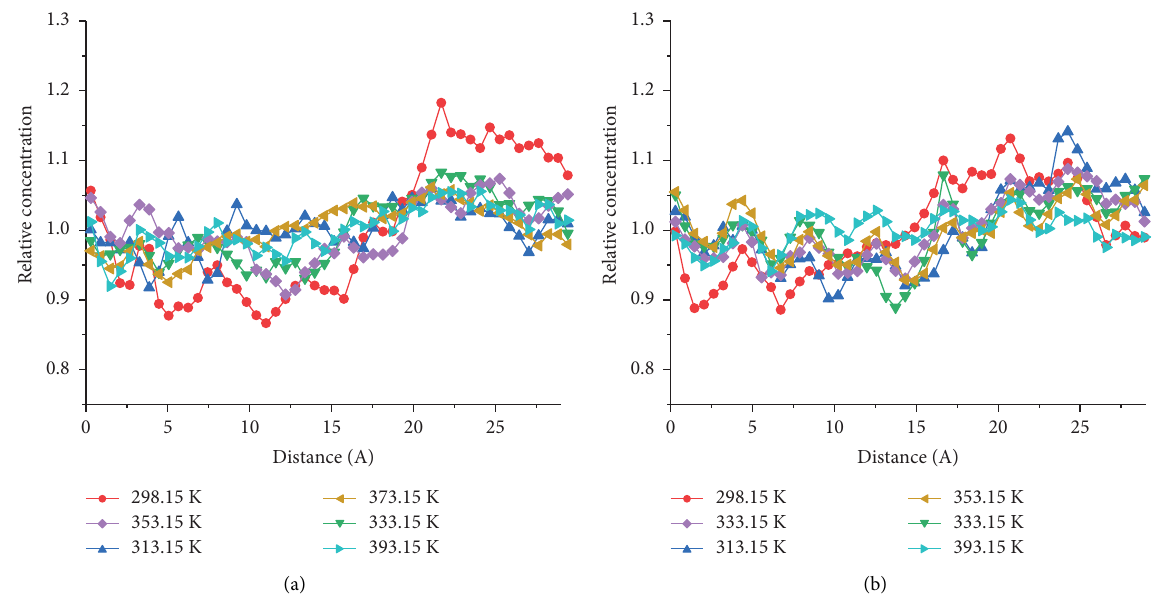
Figure 10: Relative concentration distribution for Fe 2 O 3 -asphalt model (a) and SiO 2 -asphalt model (b) in the OX direction.